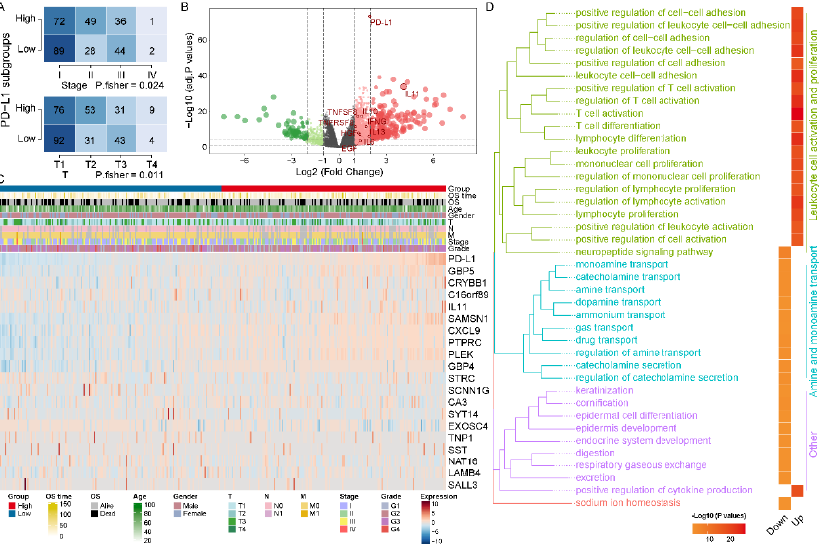
Figure 2. Different molecular characteristics between PD-L1 High and PD-L1 Low subgroups. ( A ) The distribution of pathological stage and T among PD-L1 subgroups was significantly different. ( B ) The volcano plot demonstrated differences in gene expression levels, particularly for cytokines. ( C ) The heatmap charted the expression levels of TOP10 DEGs in the PD-L1 High and PD-L1 Low subgroups, respectively. ( D ) TOP 20 biological processes in GO summary of DEGs in PD-L1 subgroups. GO biological processes are grouped according to the functional theme and plotted for PD-L1 subgroups.